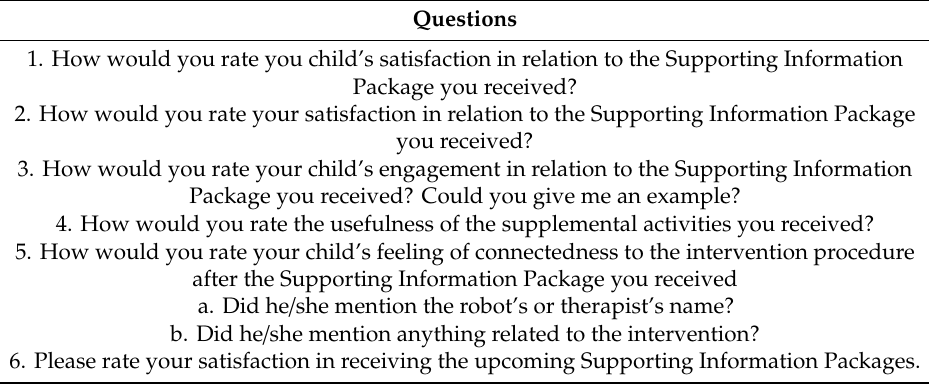
Table 2. List of phone survey